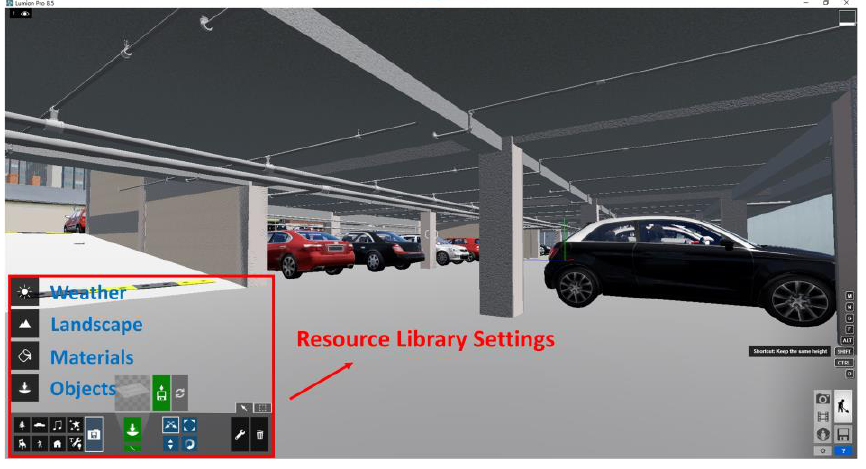
Figure 3. Resource library setting.